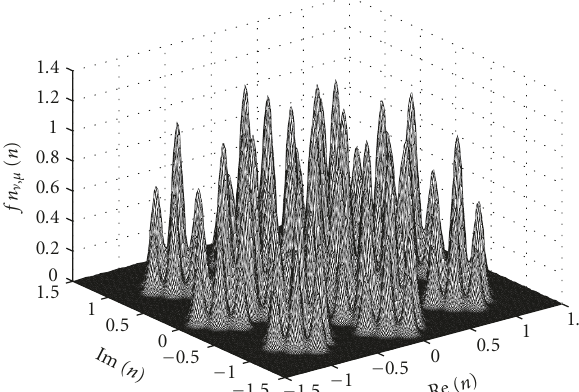
Figure 2: Approximation of actual pdf of ISI, MAI, and noise for ( E b / N 0 ) = 25 10log 10